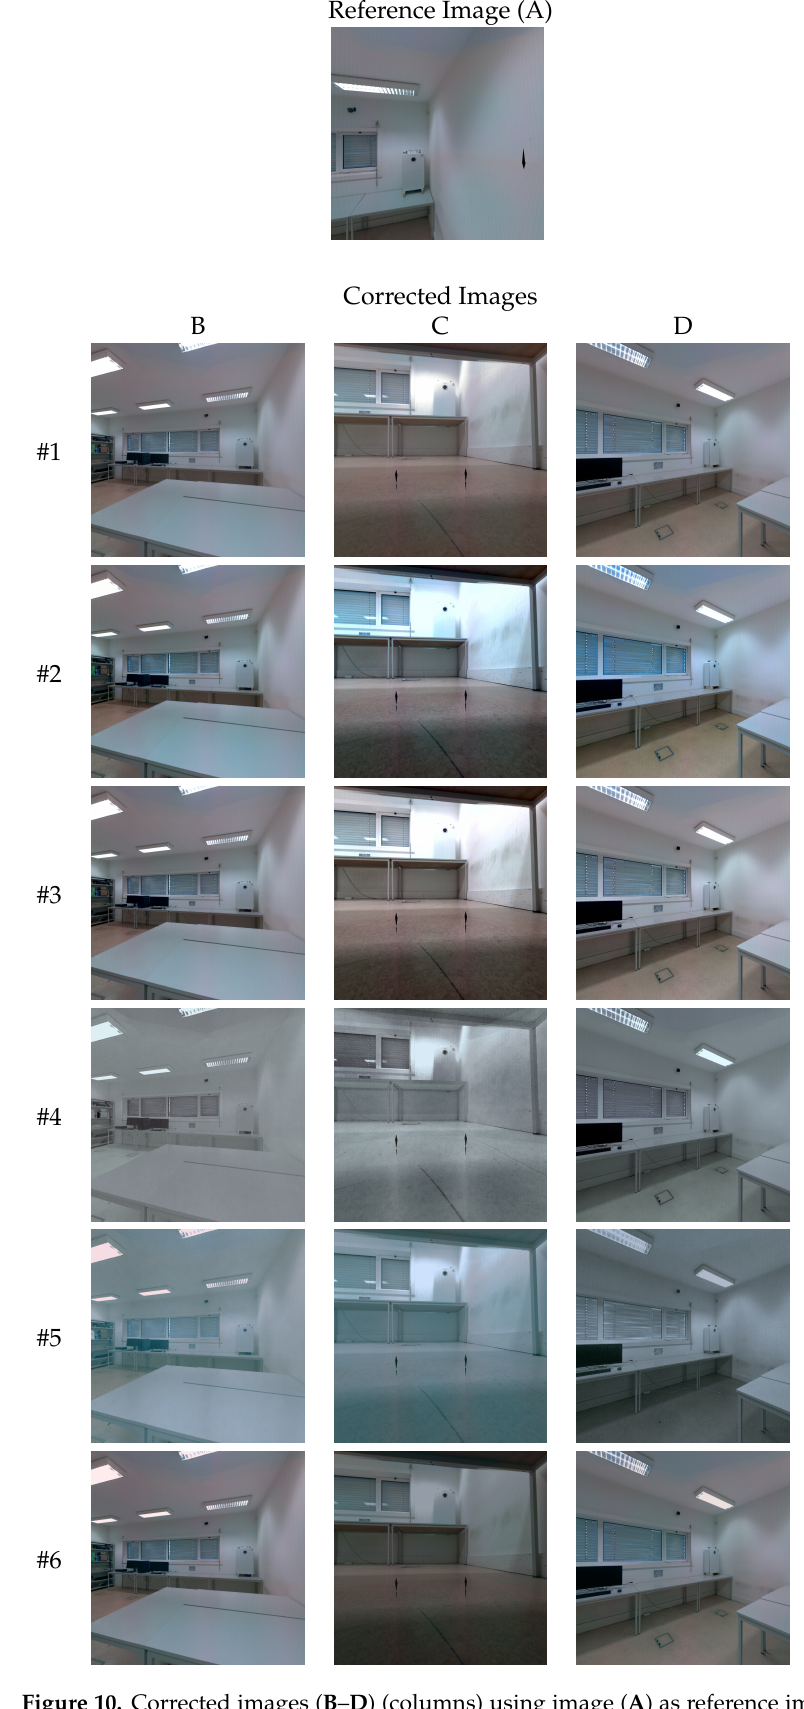
Figure 10. Corrected images ( B – D ) (columns) using image ( A ) as reference image (source image). Each row corresponds to a different color correction